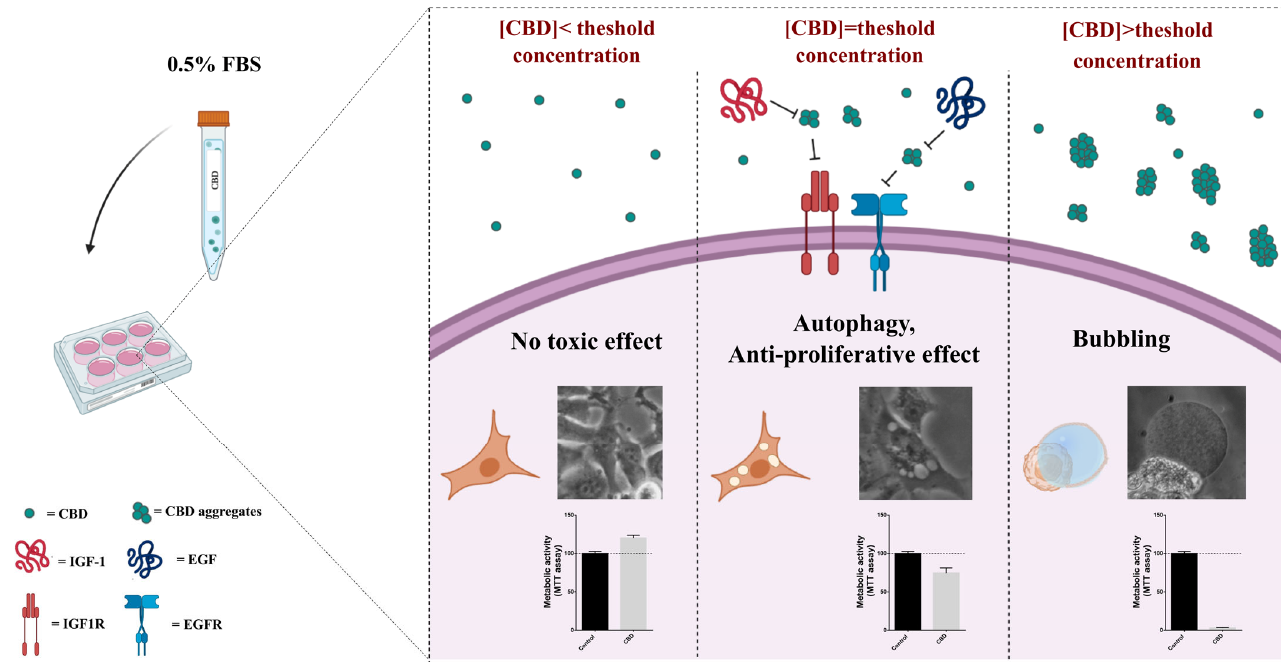
Figure 8. Schematic representation of biological effects exerted by CBD on cells.